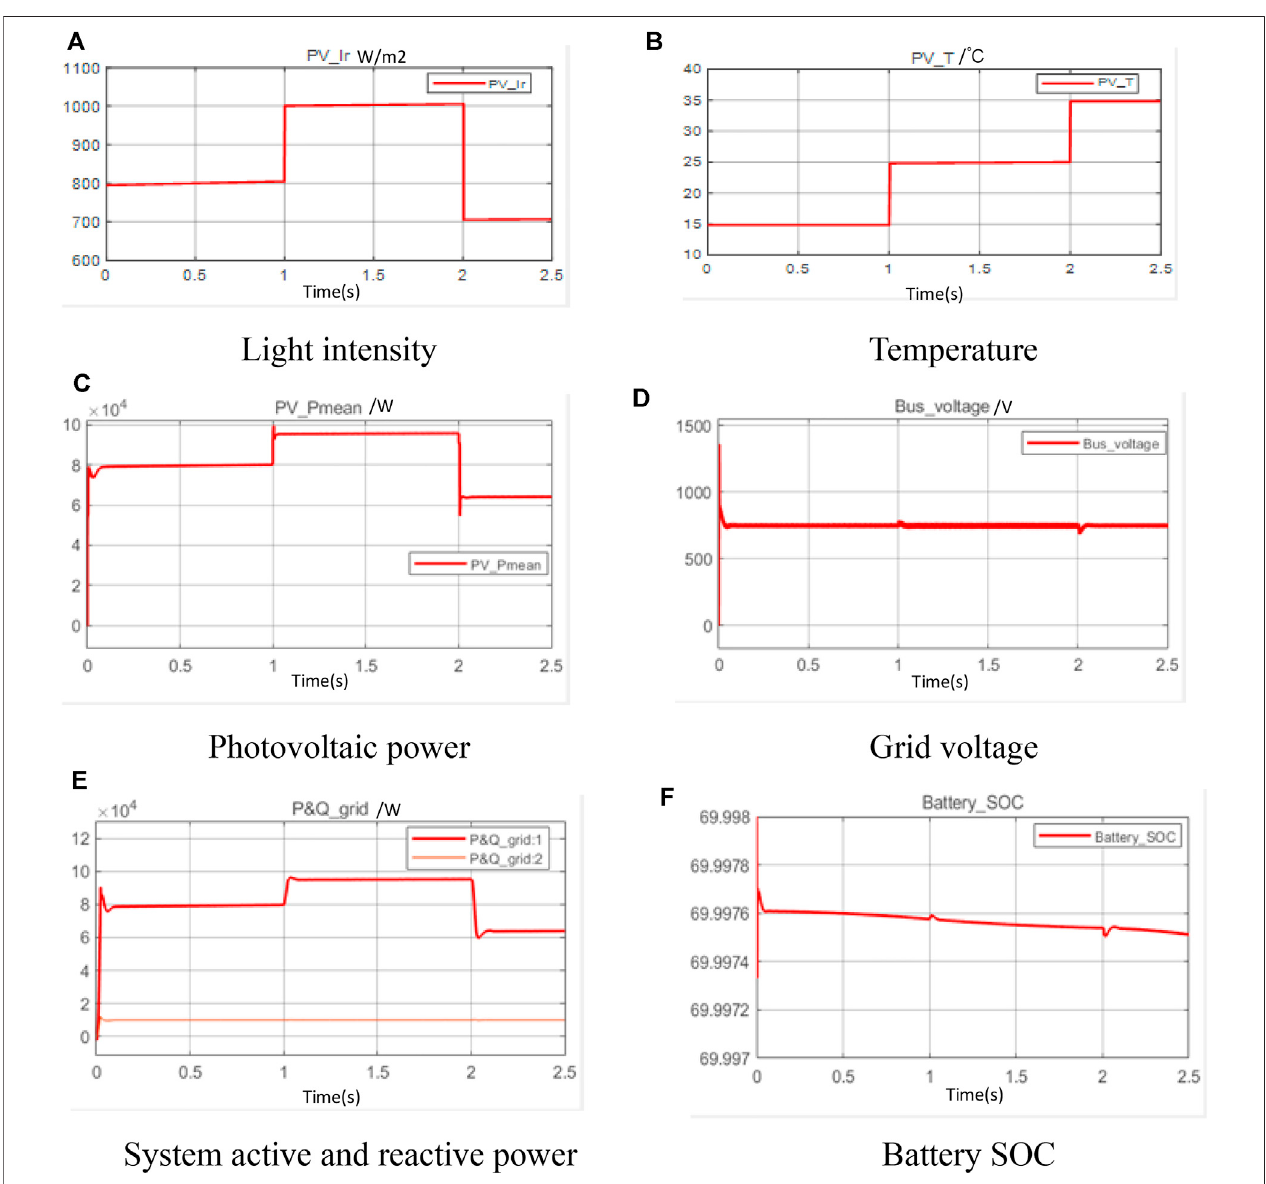
FIGURE 9 | Dynamic response in case 2. (A) Light intensity (B) Temperature (C) Photovoltaic power (D) Grid voltage (E) System active and reactive power (F) Battery SOC.